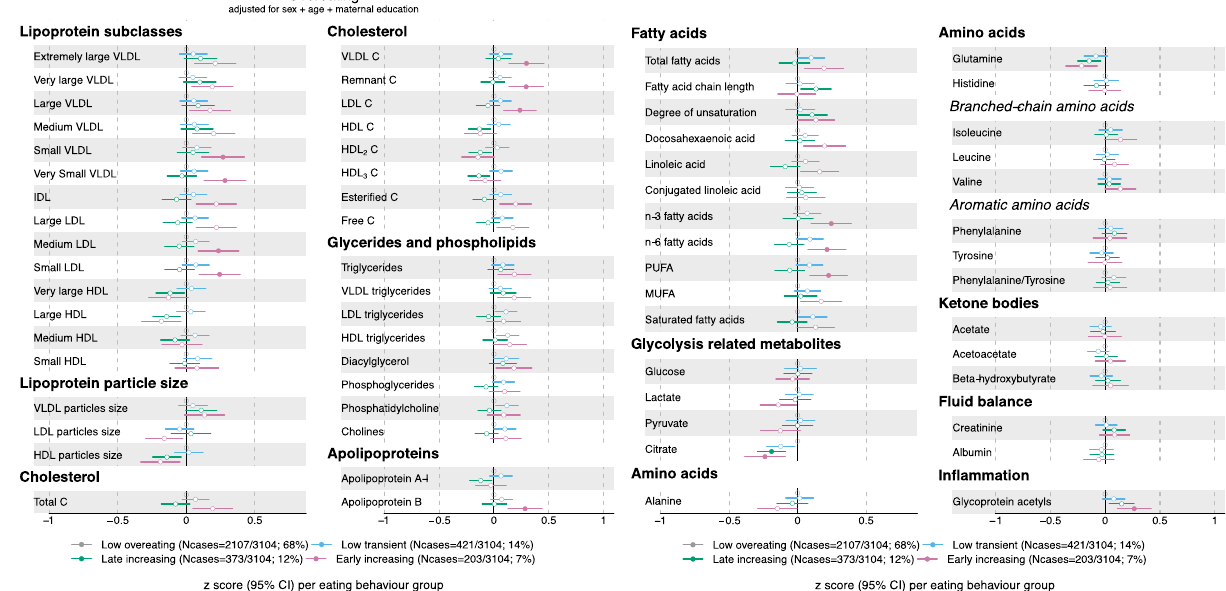
Figure 2. Estimates refer to change in standardised metabolic marker concentration at 16 years in each overeating trajectory, in reference to the “low overeating” trajectory (gray dot). Error bars = 95% confidence intervals (CI). For lipoprotein subclasses, the total lipids (= triglycerides + phospholipids + total cholesterol) point estimate (and CIs) of each 14 subclasses is presented. Estimated beta coefficients and corresponding 95% CIs for particle concentration and specific lipids in each lipoprotein subclass are given in Figure S1a–c, Supplementary Material and Table S1, Supplementary File. Analyses adjusted for sex, age at metabolite measure and maternal education. Note: Association where CIs do not cross 0, p-value < 0.05; Filled dot: Association meets the p-value threshold of < 0.003. C cholesterol, IDL intermediate-density lipoprotein, LDL low-density lipoprotein, HDL high-density lipoprotein, VLDL very low-density lipoprotein, MUFA monounsaturated fatty acids, PUFA polyunsaturated fatty acids. Note Filled dot: CI do not include the null after multiple testing correction. MUFA, PUFA and saturated fatty acid concentrations include all fatty acids detected which have one, more than one, or zero C=C double bonds in their backbone,